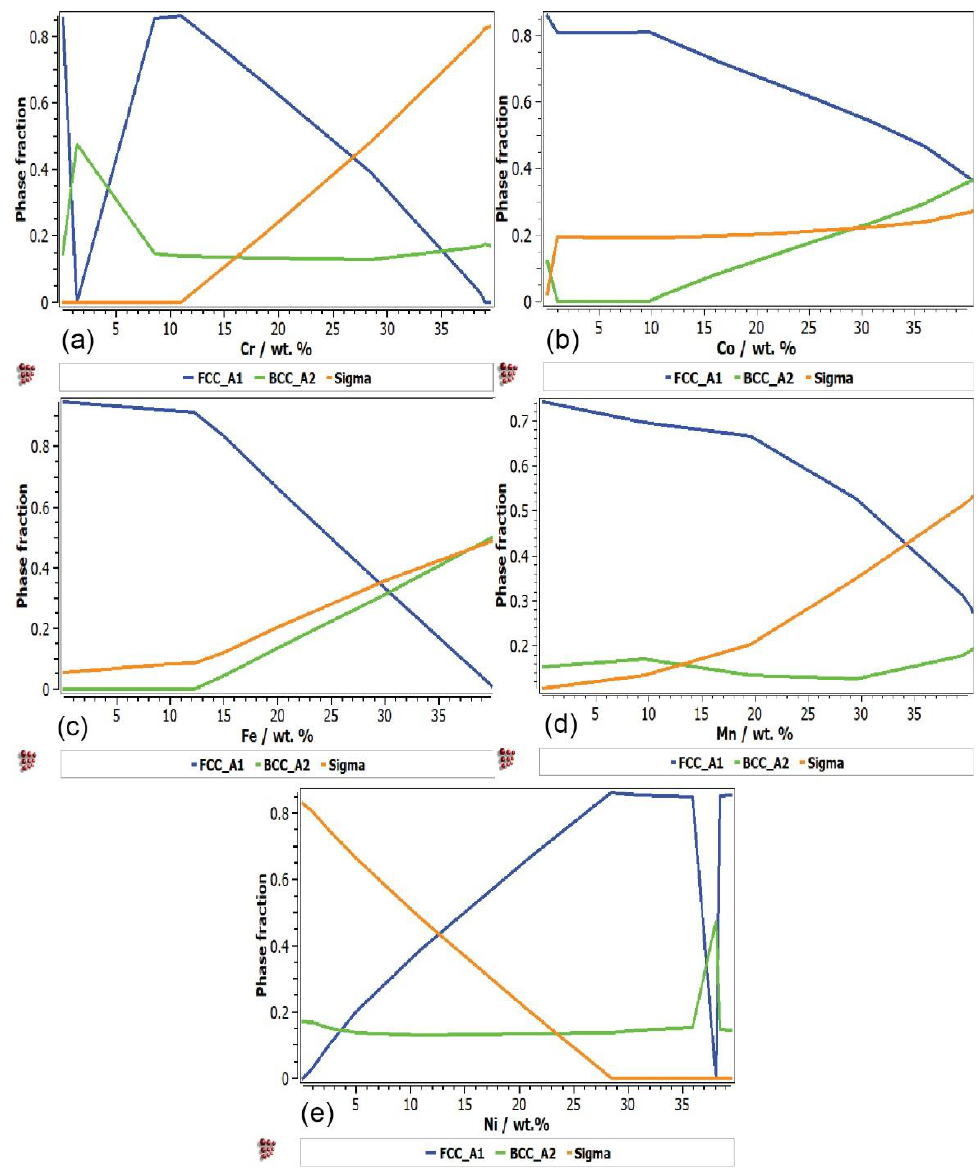
Figure 1. Effect of the elemental content on the phase constitution at 350 °C: ( a ) Co; ( b ) Cr; ( c ) Fe; ( d ) Mn; and ( e ) Ni.